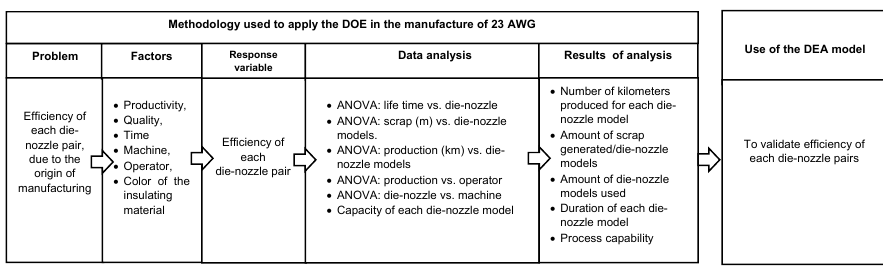
Figure 4. Explain the steps to apply the proposed methodology, data analysis through ANOVA and validation of results with DEA model.